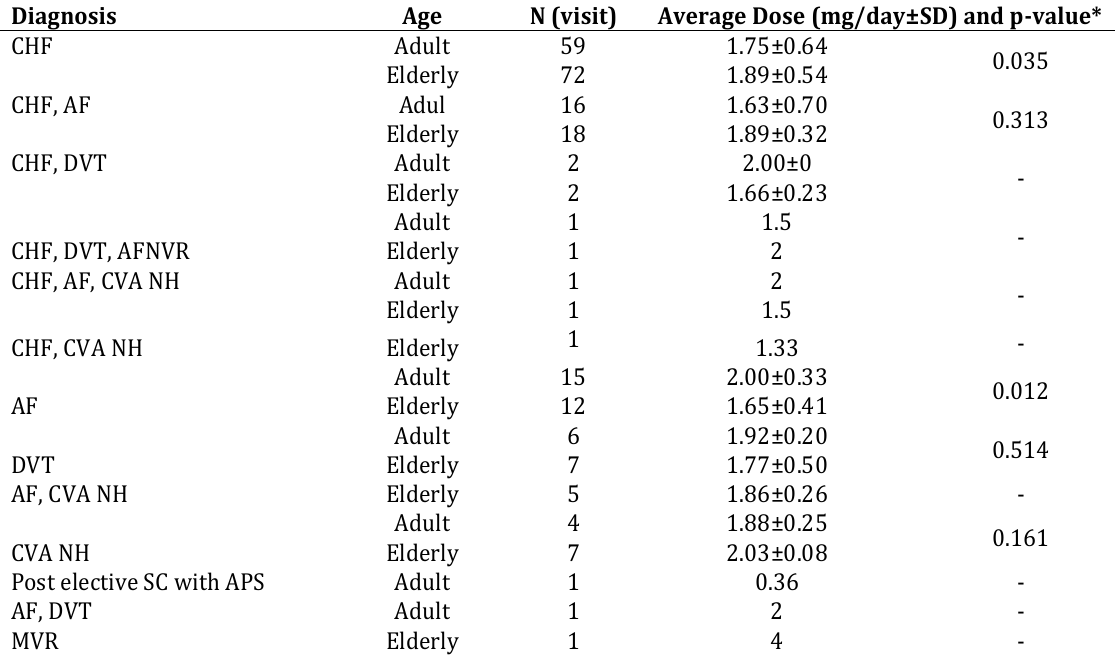
Table II. Average Warfarin Dose for Each Diagnosis Category and Age Group